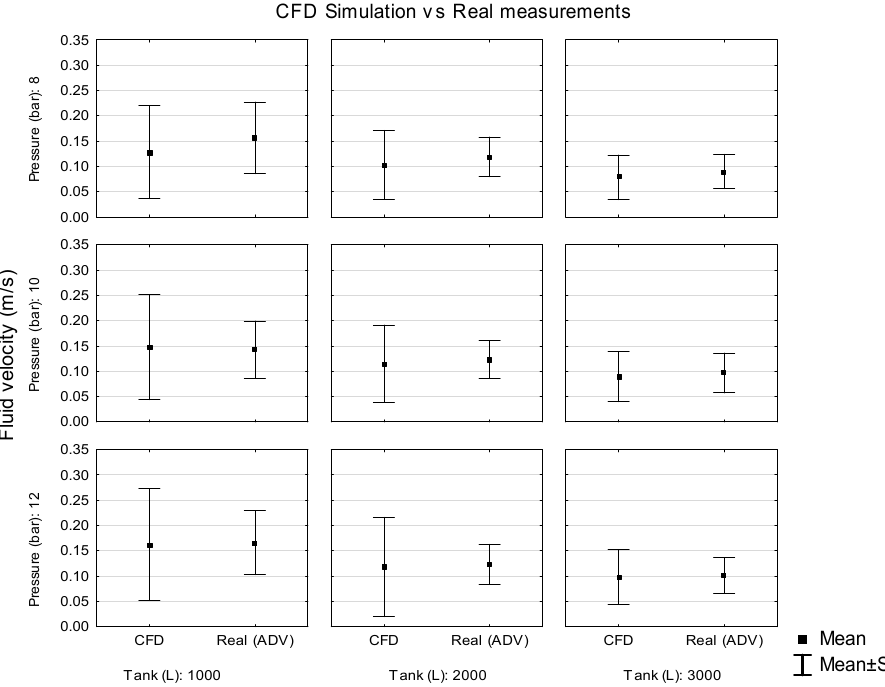
Figure 6. Mean fluid velocities, estimated by CFD and experimentally measured, according to the level of water in the tank and pressures of the nozzle circuits.